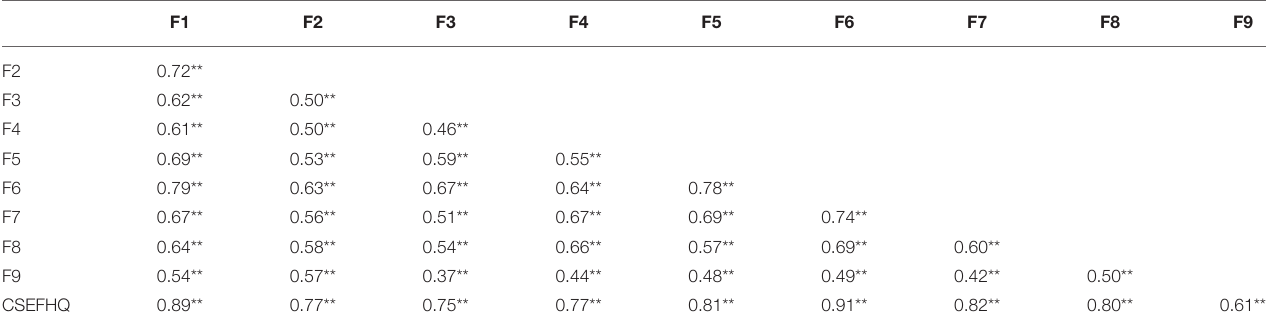
TABLE 4 | The correlation between the scores of factors and the total score of the CSEFHQ ( N = 696). F1 F2 F3 F4 F5 F6